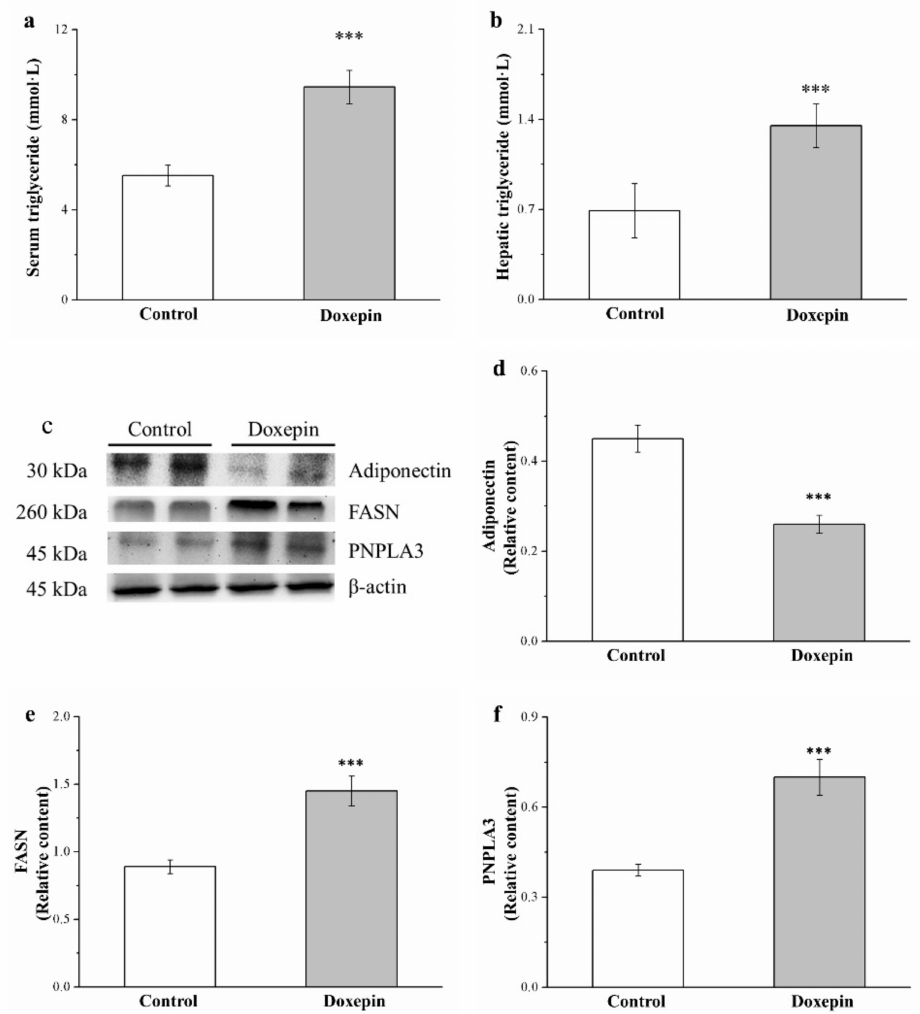
Figure 5. ( a ) Serum and ( b ) liver triglyceride levels, ( c ) representative Western blot of liver extracts, and ( d ) adiponectin, ( e ) FASN, and ( f ) PNPLA3 expression levels in the controls and doxepin-treated obese mice over 56 treatment days. All values represent the mean ± standard deviation ( n = 10 for all groups). *** p < 0.001 indicates very high statistical